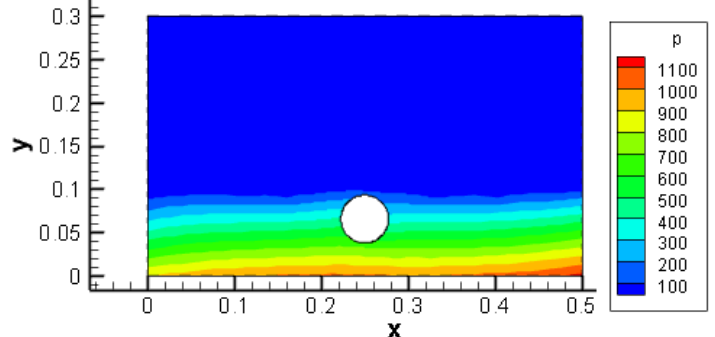
Figure 4. Pressure distribution of fill level = 37% and 0.6 × h f distance from the bottom at t = 0.1 × ( s ) . Pressure and velocity in liquid for filling level = 37% and 0.6 × h f distance from bottom at t = 1 × ( s ) appear in Figure 5. Velocity near the cylinder in the fluid stage is higher than the other points. As is shown, the existence of the baffle causes fluid flow stratification. Due to the tuned liquid damper, the zone of fluid wet divider is bigger; accordingly, it sets aside more opportunity for the viscous effect to be exchanged to the bulk fluid.